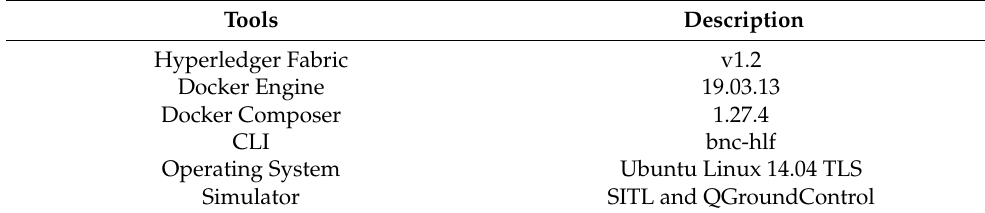
Table 3. Development